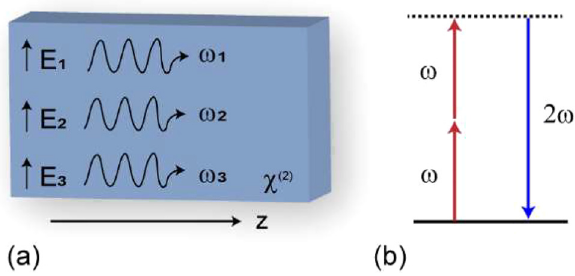
Figure 1: (a) Three waves with frequencies ω 1 , ω 2 , and ω 3 mix in a nonlinear optical crystal exhibiting second-order ( χ (2) ) effects, propagating in the z -direction. (b) For second-harmonic generation (SHG), two photons at the pump frequency are destroyed while interacting with the material to produce a single photon at double the pump frequency (half the